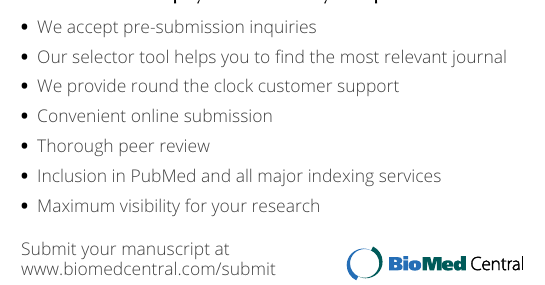
Additional file 1: Table 1. List of excluded generalist MeSH terms in the context of an analysis in the field of allergy and immunology. Table 2 . Temporal trends of MeSH terms of each thematic category (results obtained by univariable logistic regression, with the year of publication as independent variable) (A), and absolute and relative frequencies of MeSH terms of each thematic category (B) among Allergy, Pediatric Allergy and Immunology (PAI), and Clinical and Translational Allergy (CTA)